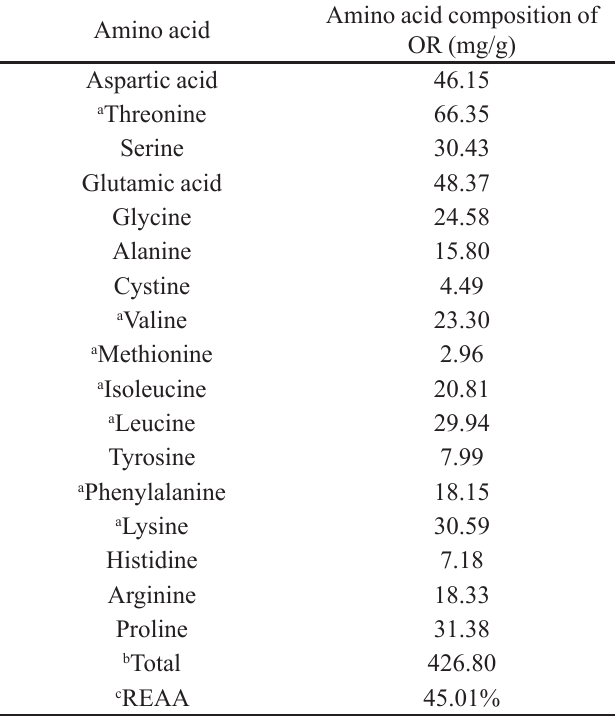
TABLE I - Amino acid composition of OR (Zhang et al .,